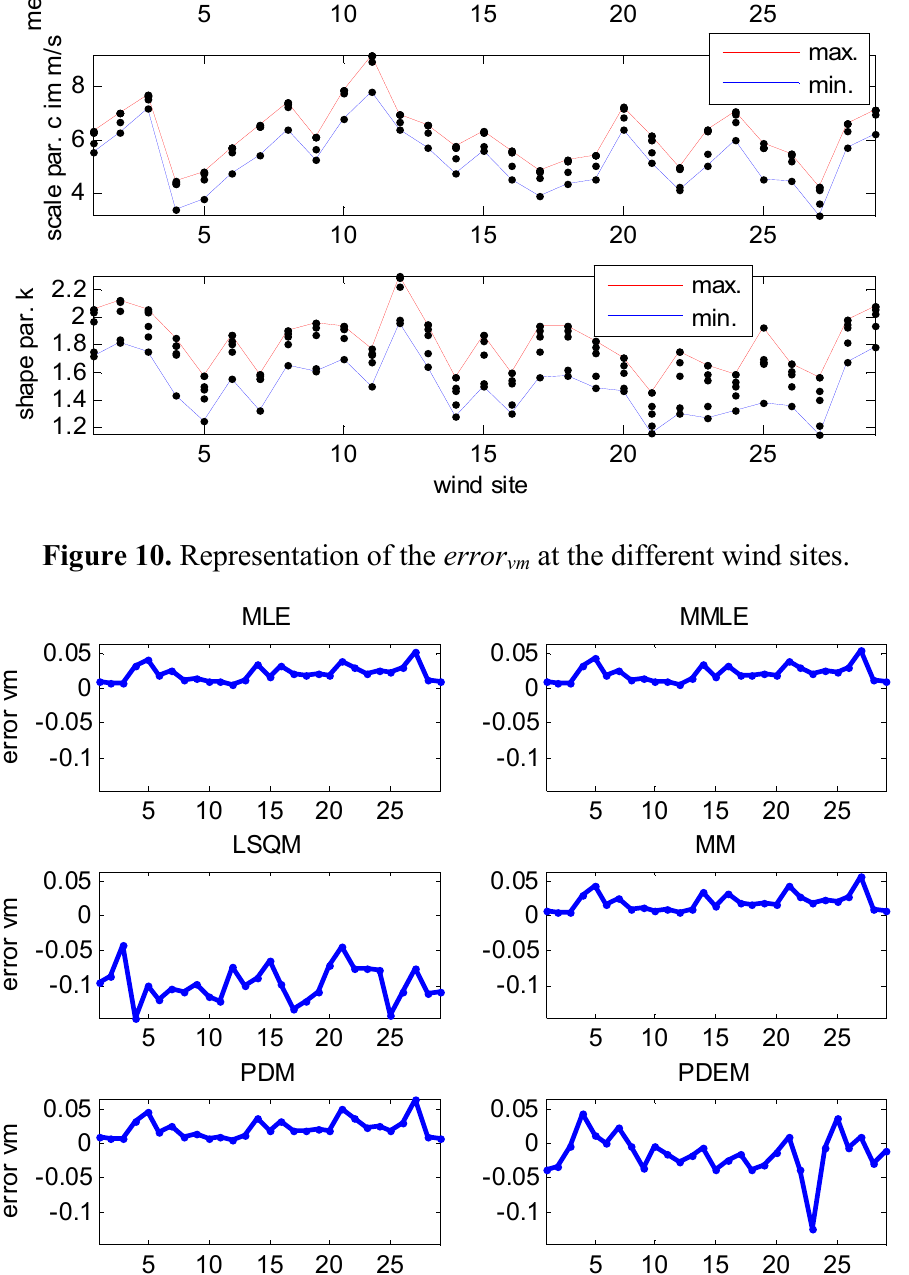
Figure 9. Representation of the mean wind speed calculated from data, scale and shape parameters for all wind sites using the different estimation methods.